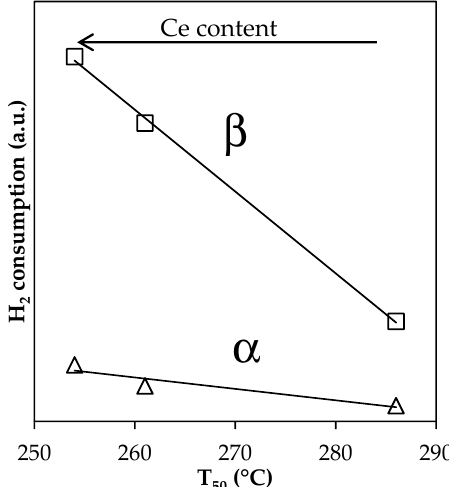
Figure 11. Evolution of H 2 -TPR data with T 50 for toluene oxidation reaction. Table 5. Comparison of catalyst performances.